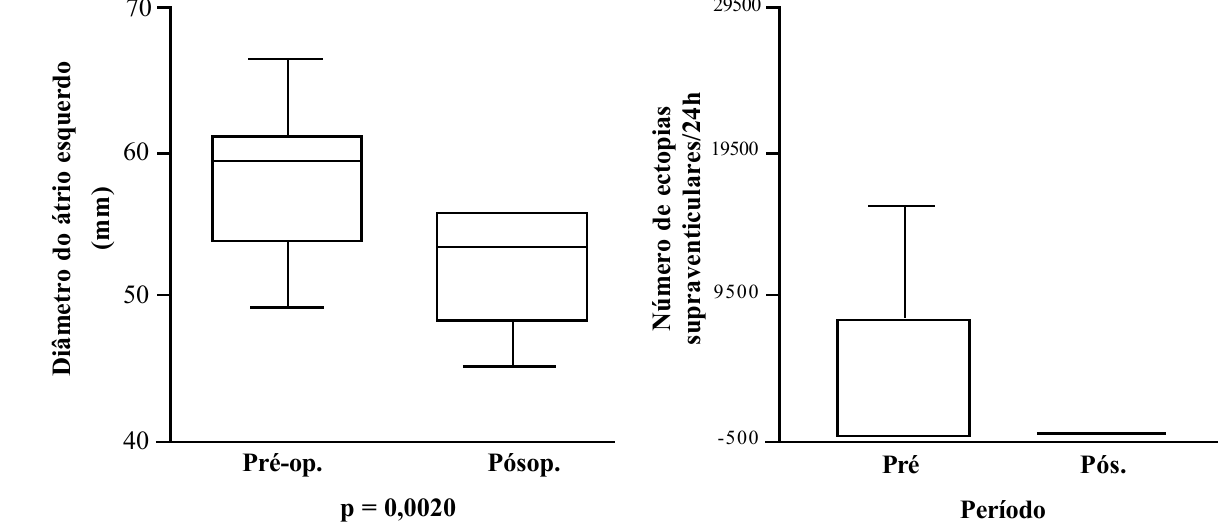
Figura 1 - Diâmetros do átrio esquerdo (mm) mensurados pelo Doppler-ecocardiograma, nos períodos pré e pós-operatório. Os limites horizontais das caixas correspondem ao 25° percentil e ao 75° percentil, a linha no interior de cada caixa denota a mediana (50° percentil) e os limites externos às caixas denotam o maior e o menor valor da variável.